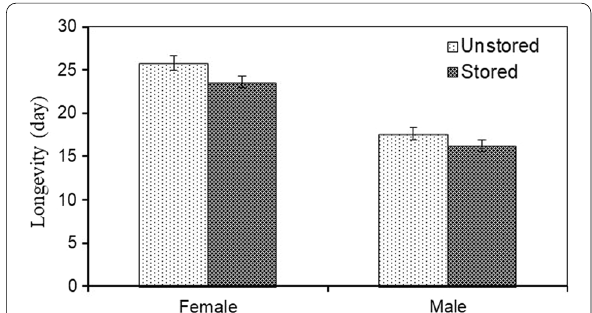
Table 1 Estimated coefficients by logistic regression of